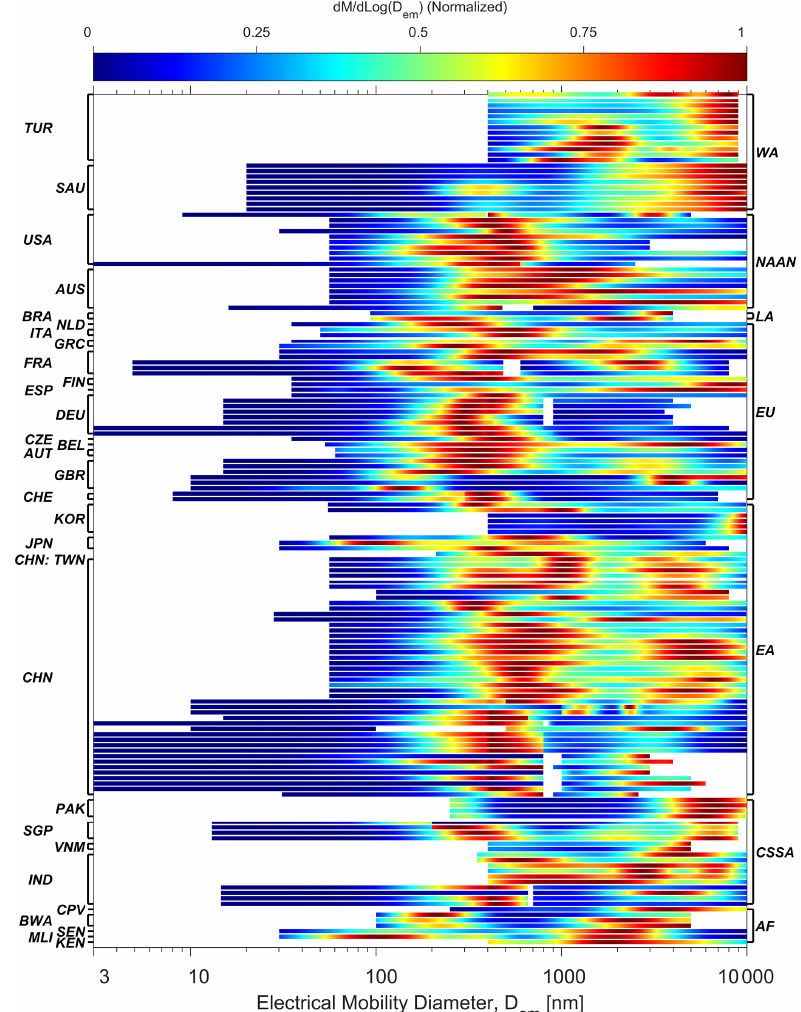
Figure 10. Normalized urban aerosol mass PSDs analyzed in this study from around the globe. The country codes are listed on the left, and the region codes are listed on the